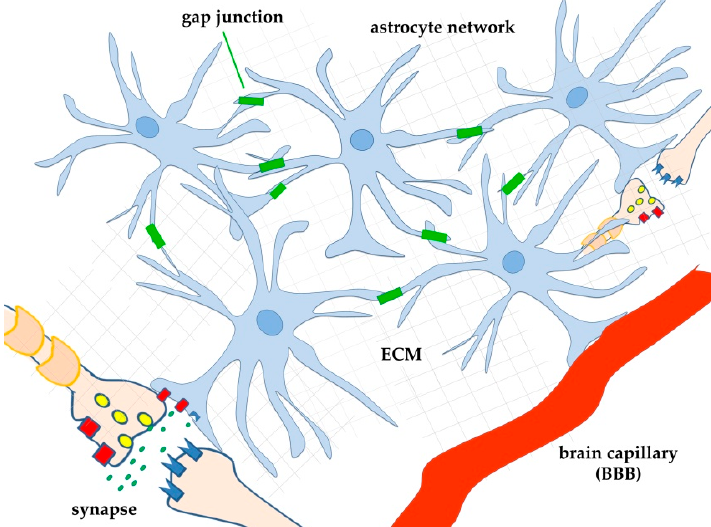
Figure 1. Schematic drawing of astrocyte interconnection by gap junctions (green rectangles). By forming a network, astrocytes can influence synapses far away from the active ones, allowing different (and distant) synapses to interact with each other also in the absence of proximity (lateral regulation of synaptic transmission by astrocytes, [86]). For simplicity, only two distant astrocytes, each interacting with one synapse (model of the tripartite synapse), and one astrocyte interacting with one brain capillary are shown. Thanks to the network, astrocytes can probably also transfer metabolites (for example, glucose) from blood to distant neurons. BBB: blood-brain-barrier; ECM: extracellular matrix.